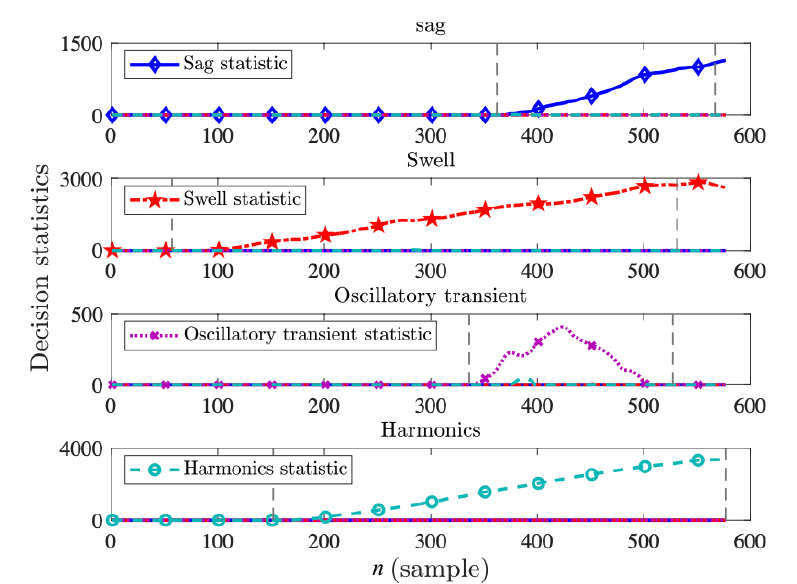
Figure 8. Decision statistics of vector-ODIT for four voltage disturbance types: sag, swell, oscillatory transient, and harmonics. The disturbance onset and ending times are shown with vertical dashed gray lines. When the disturbance starts, the corresponding decision statistic successfully increases steadily, while the other decision statistics remain around